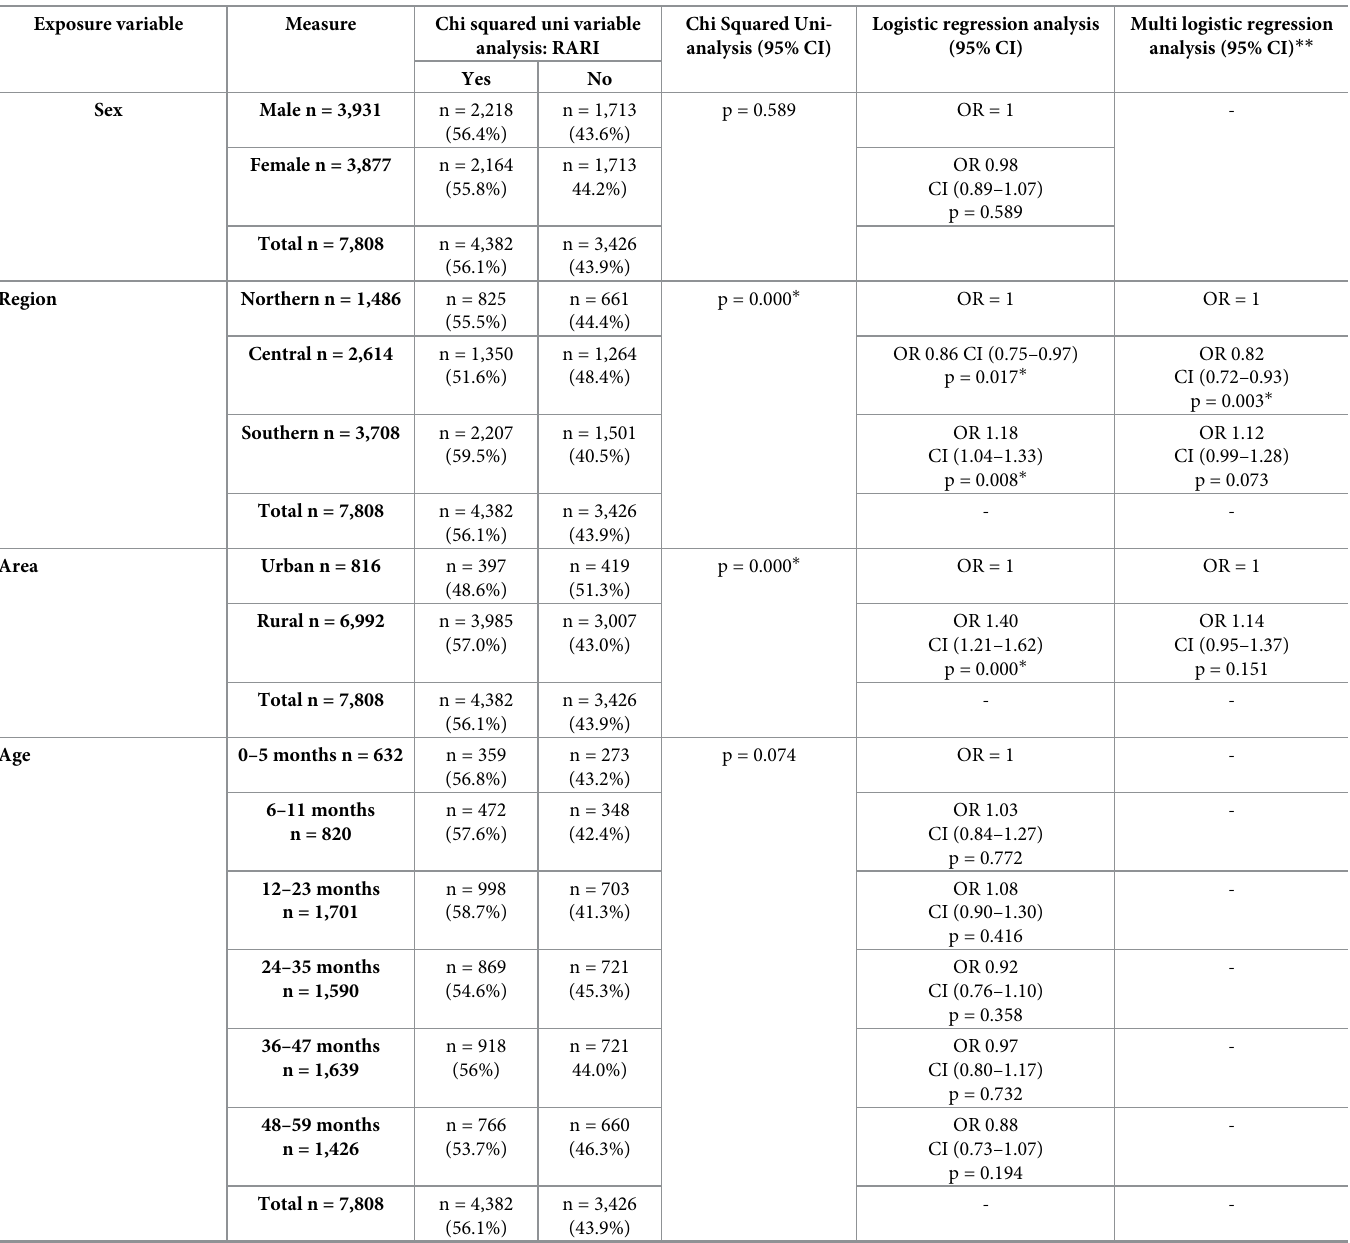
Table 2. Socio-economic associations with RARI in children under